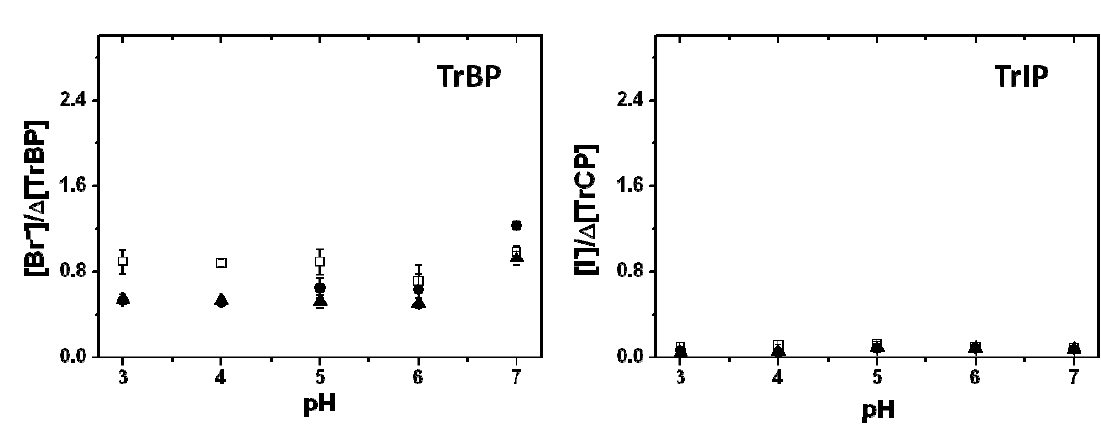
Figure 4. ( a ) Influence of catalyst concentrations on Δ [TrCP]; ( b ) Turnover numbers (TONs) for each catalyst. Conditions: pH 3, [TrXP] 150 μ M, [KHSO